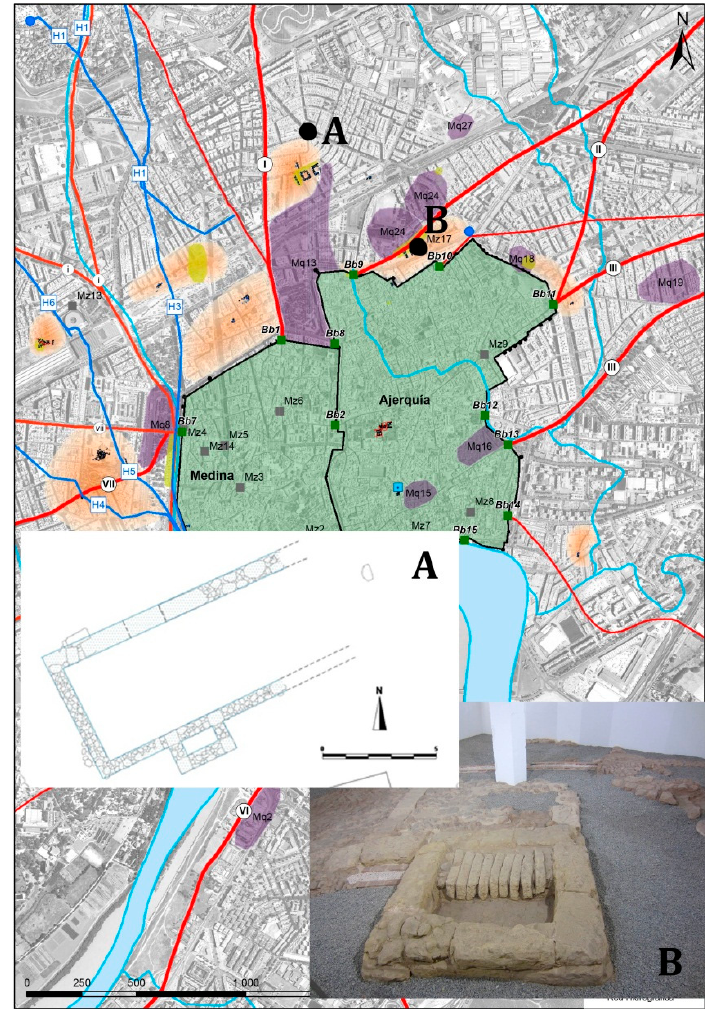
Figure 7. Mosques built after the fall of the Caliphate. ( A ) Mosque in Santa Rosa. ( B ) Mosque in Ollerías neighborhood (picture by author). Basis plan: Vaquerizo and Murillo 2010, p. 707, Figure 369. All images used by the permission of authors.